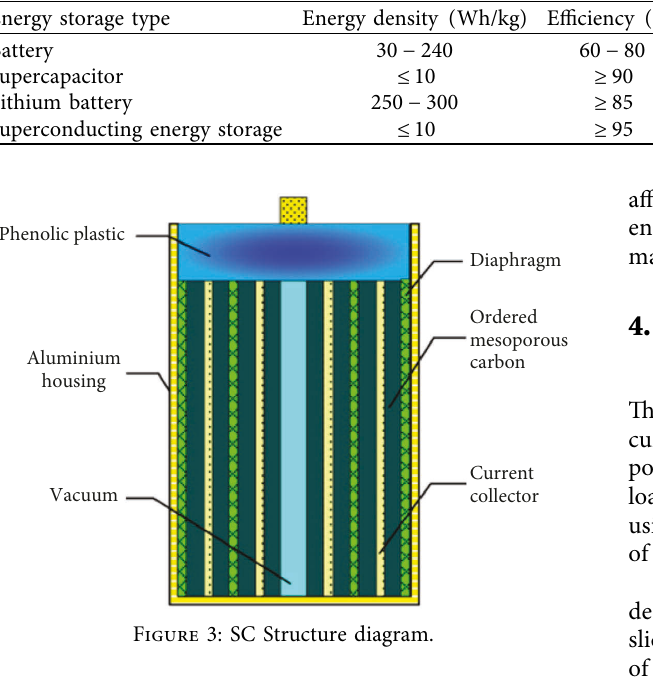
Table 1: Main specifications of common energy storage.